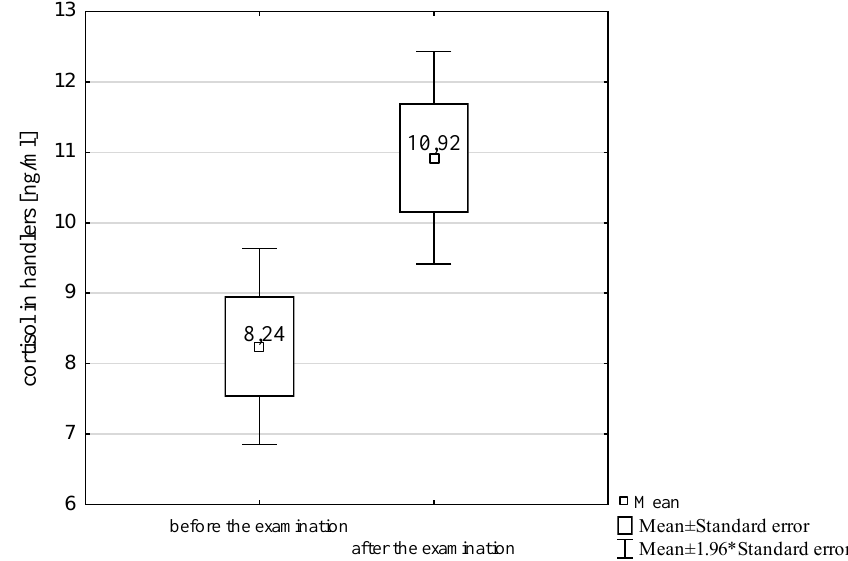
Figure 1. Box plot of the cortisol level in the dog handlers before and after the examination.